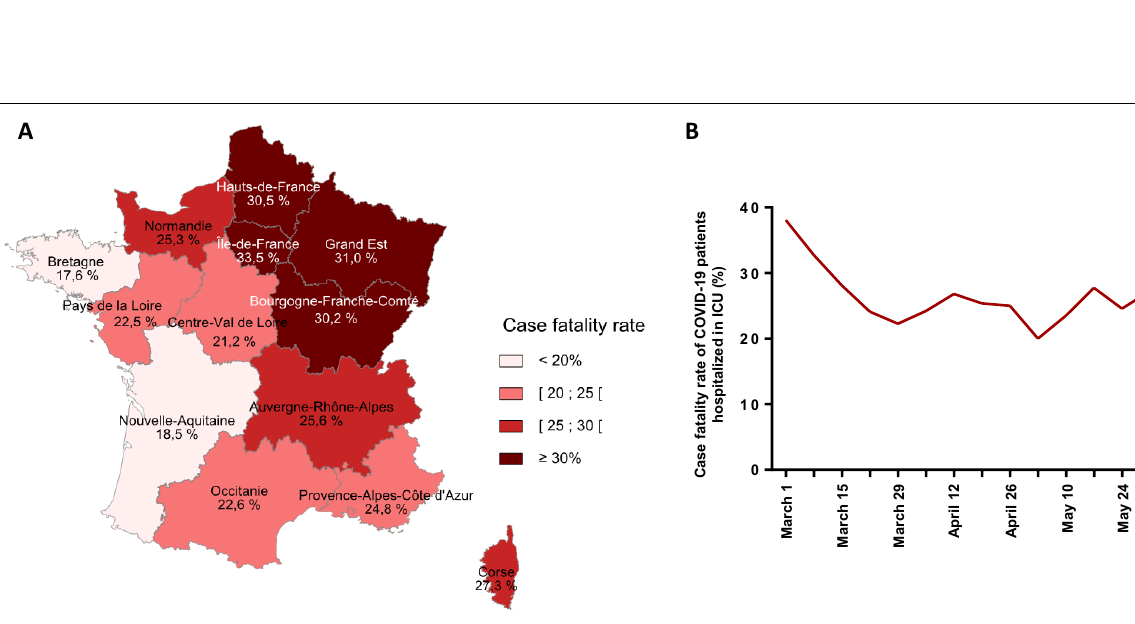
Fig. 2 Case fatality rate of COVID‑19 patients admitted to ICU in France, March 1st to May 31st, 2020. Case fatality rate of COVID‑19 patients according to: A the French administrative region, B the date of